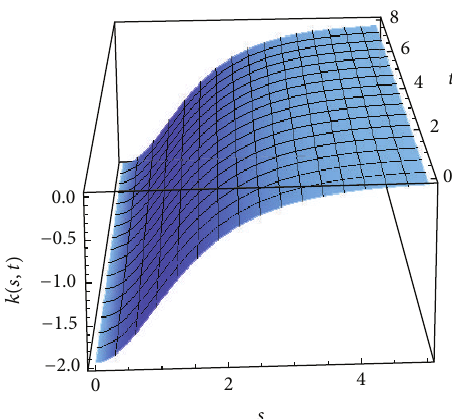
Figure 1: The curvature of the family of curves 𝐶 𝑡 for 𝑠 ∈ [0, 5] , Figure 4: The surface that is generated by the motion of the family = 1 , 𝑐 = −0.001 , and 𝑐 = 0 . 𝑡 ∈ [0, 8] , 𝑎 = 0.5 , 𝑐 of curves 𝐶 𝑡 for 𝑠 ∈ [0,5] , 𝑡 ∈ [0,3] , 𝑎 = 0.6 , 𝑐 1 = 1 , 𝑐 2 = 0.01 , 𝑐 3 = 0 , 1 2 3 and 𝑐 4 = 1 . The bold black curves in this surface represent the family of curves 𝐶 𝑡 for 𝑡 = 0, 1, 2